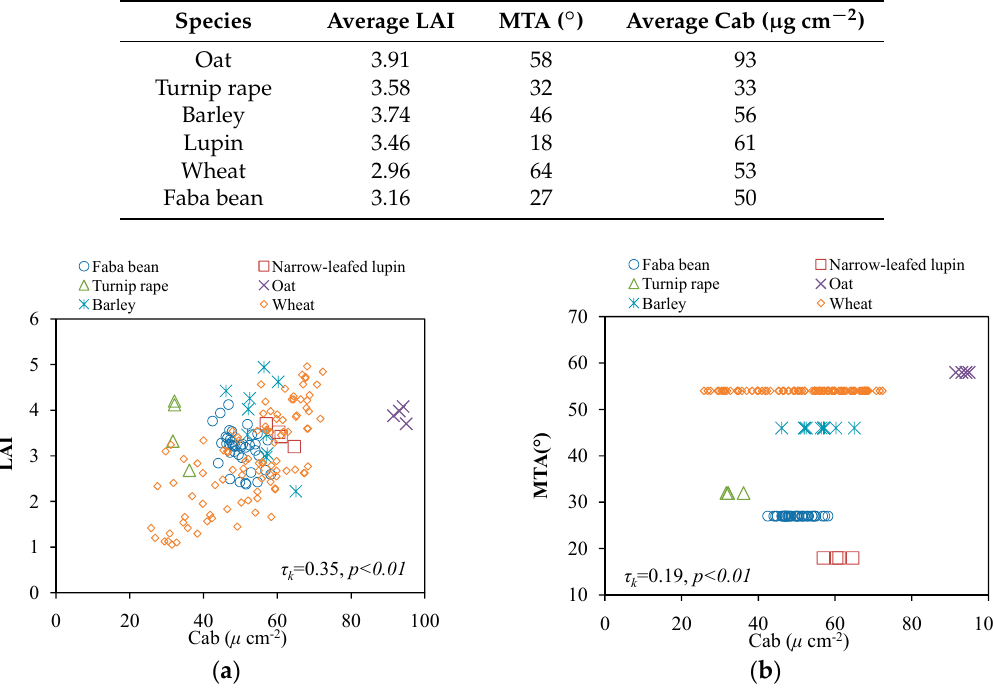
Figure 4. Correlation between field-measured LAI, the chlorophyll a and b content (Cab), and the leaf mean tilt angle (MTA): ( a ) field-measured LAI and Cab; ( b ) photographic MTA and Cab. All used VIs were correlated with LAI in both the field-measured and model-simulated data (Table 4), with τ k between 0.34 and 0.64. For the field-measured data (Figure 5), the rank correlation coefficients were all above 0.4, except for MSAVI, MSR 705 , and SAVI ( τ k = 0.34–0.36), and with GARI and GNDVI performing best among the tested VIs ( τ k = 0.50). In model simulations (Figure 6), GARI and GNDVI produced the lowest τ k of 0.38, with BNDVI being the most strongly correlated ( τ k = 0.64). All the relationships for both empirical analysis and model simulations were significant ( p < 0.01). Table 4. Kendall’s rank correlation coefficient ( τ k ) between vegetation indices and LAI for model simulations and field-measured data. All correlations were statistically significant ( p <